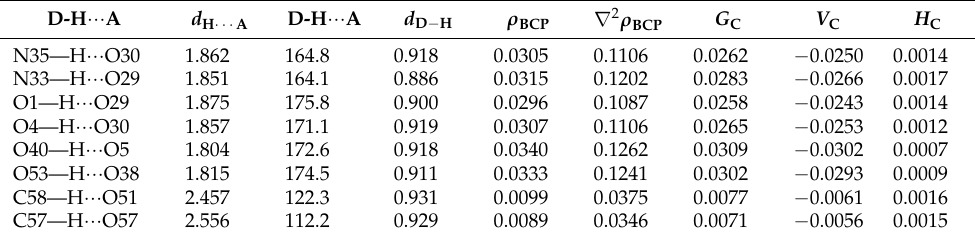
Table 2. Geometrical parameters (d H ··· o in Ångstrom and < D-H ··· A in degrees) corresponding to the D-H ··· A contacts obtained at the B3LYP/6-311++G(d,p); QTAiM parameters (in atomic unit) corresponding to the H ··· O bond critical point (BCPs), the electron density at BCP ρ BCP ; Laplacian of electron density at BCP, ∇ 2 ρ BCP ; total electron energy density at BCP, H C and the components of the H C : kinetic electron energy density, G C ; potential electron energy density, V C . The atomic labeling is presented in Figure 6.